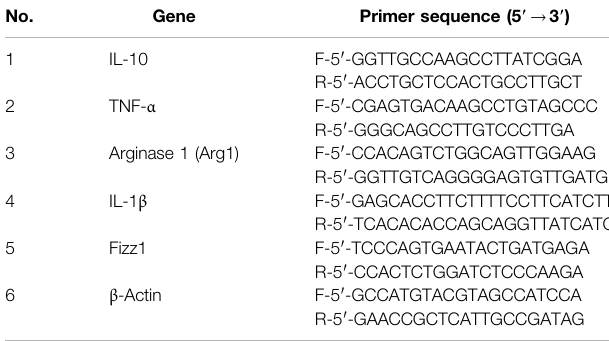
TABLE 1 | Primer sequences of the